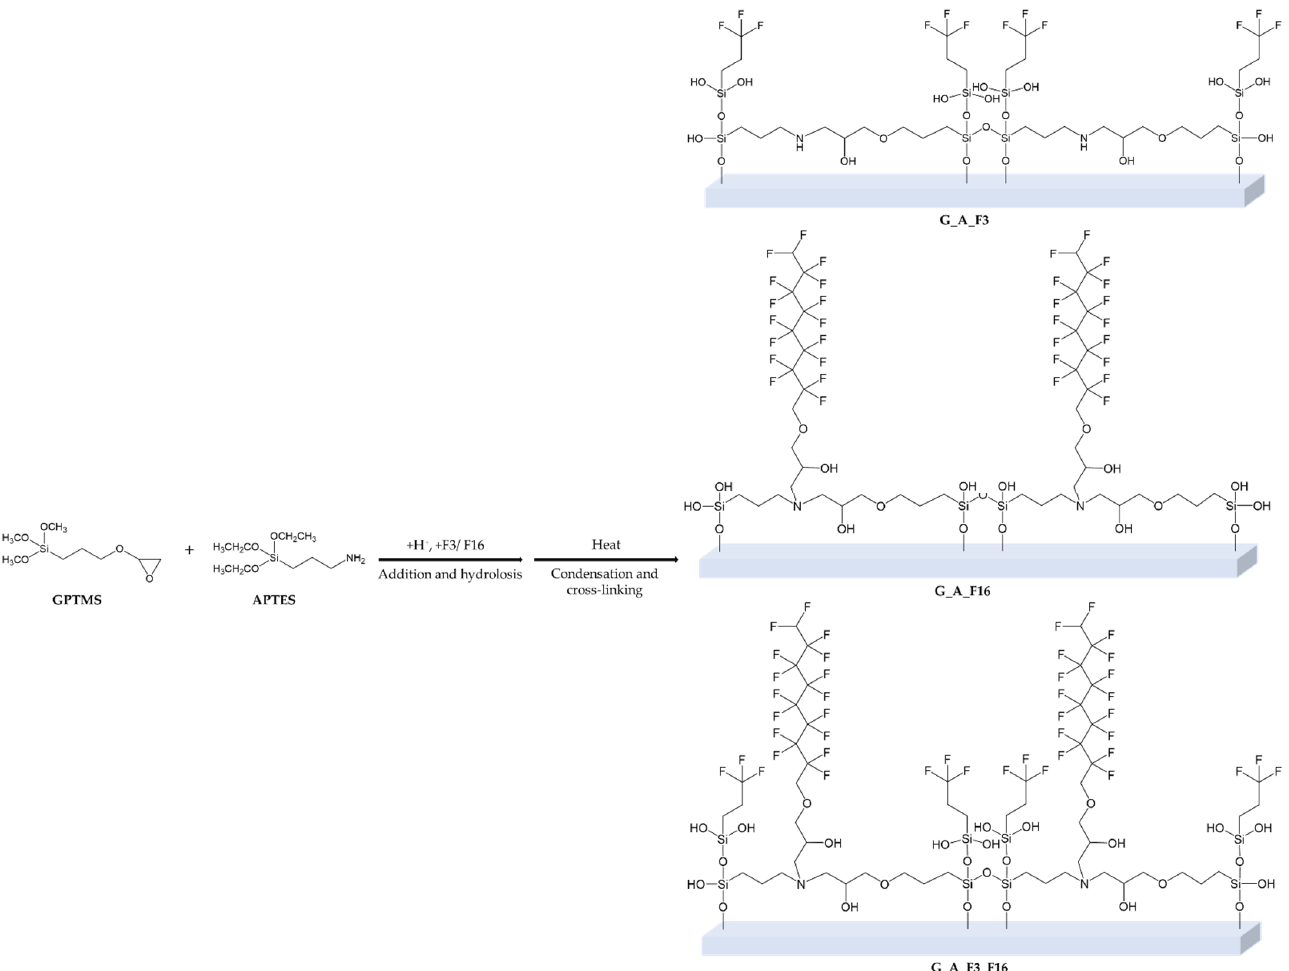
Figure 5. Sol–gel synthesis towards the formation of the three functional G_A_F3, G_A_F16, G_A_F3_F16 coating by reaction of GPTMS/APTES (2:1), and F3 and F16 (overall 5 wt%).